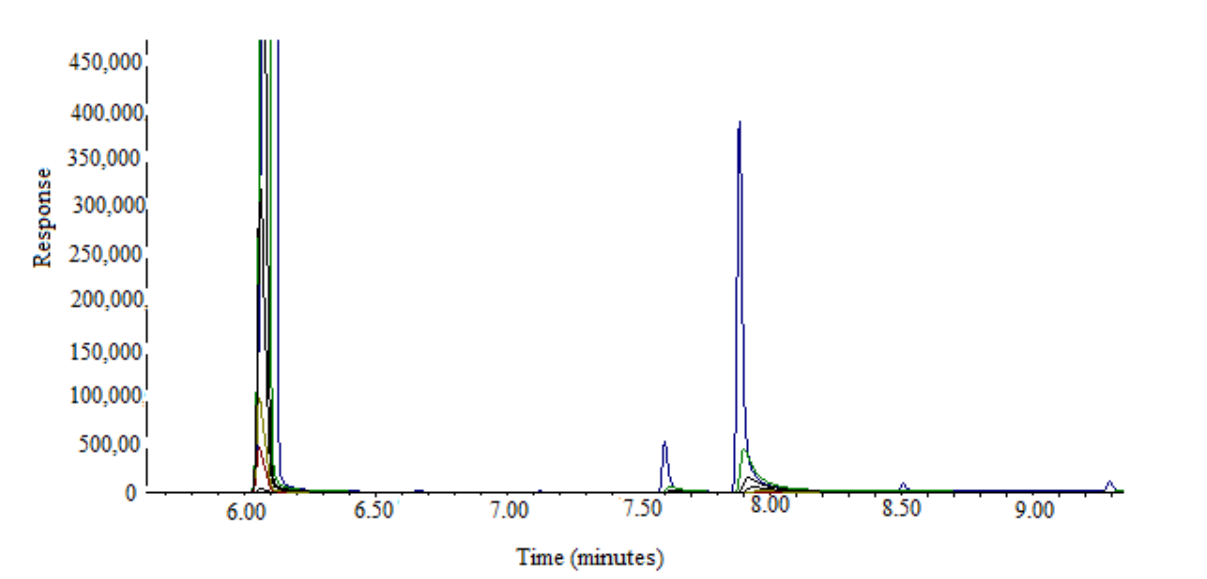
Figure 6. Overlaid GC-MS spectra of standard FCO and TOH at different concentrations.